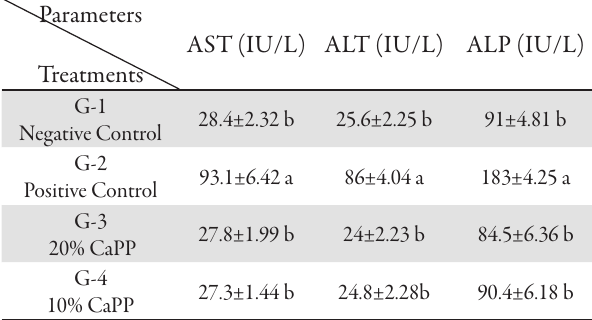
Tab. 5. Plasma ALT, AST and ALP activities (IU/L) in the experimental